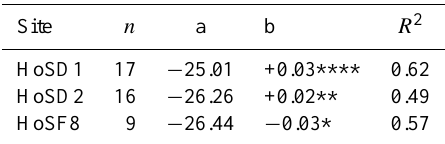
Table 3. Regression coefficients for the function depth = a+b . δ 13 C in the investigated